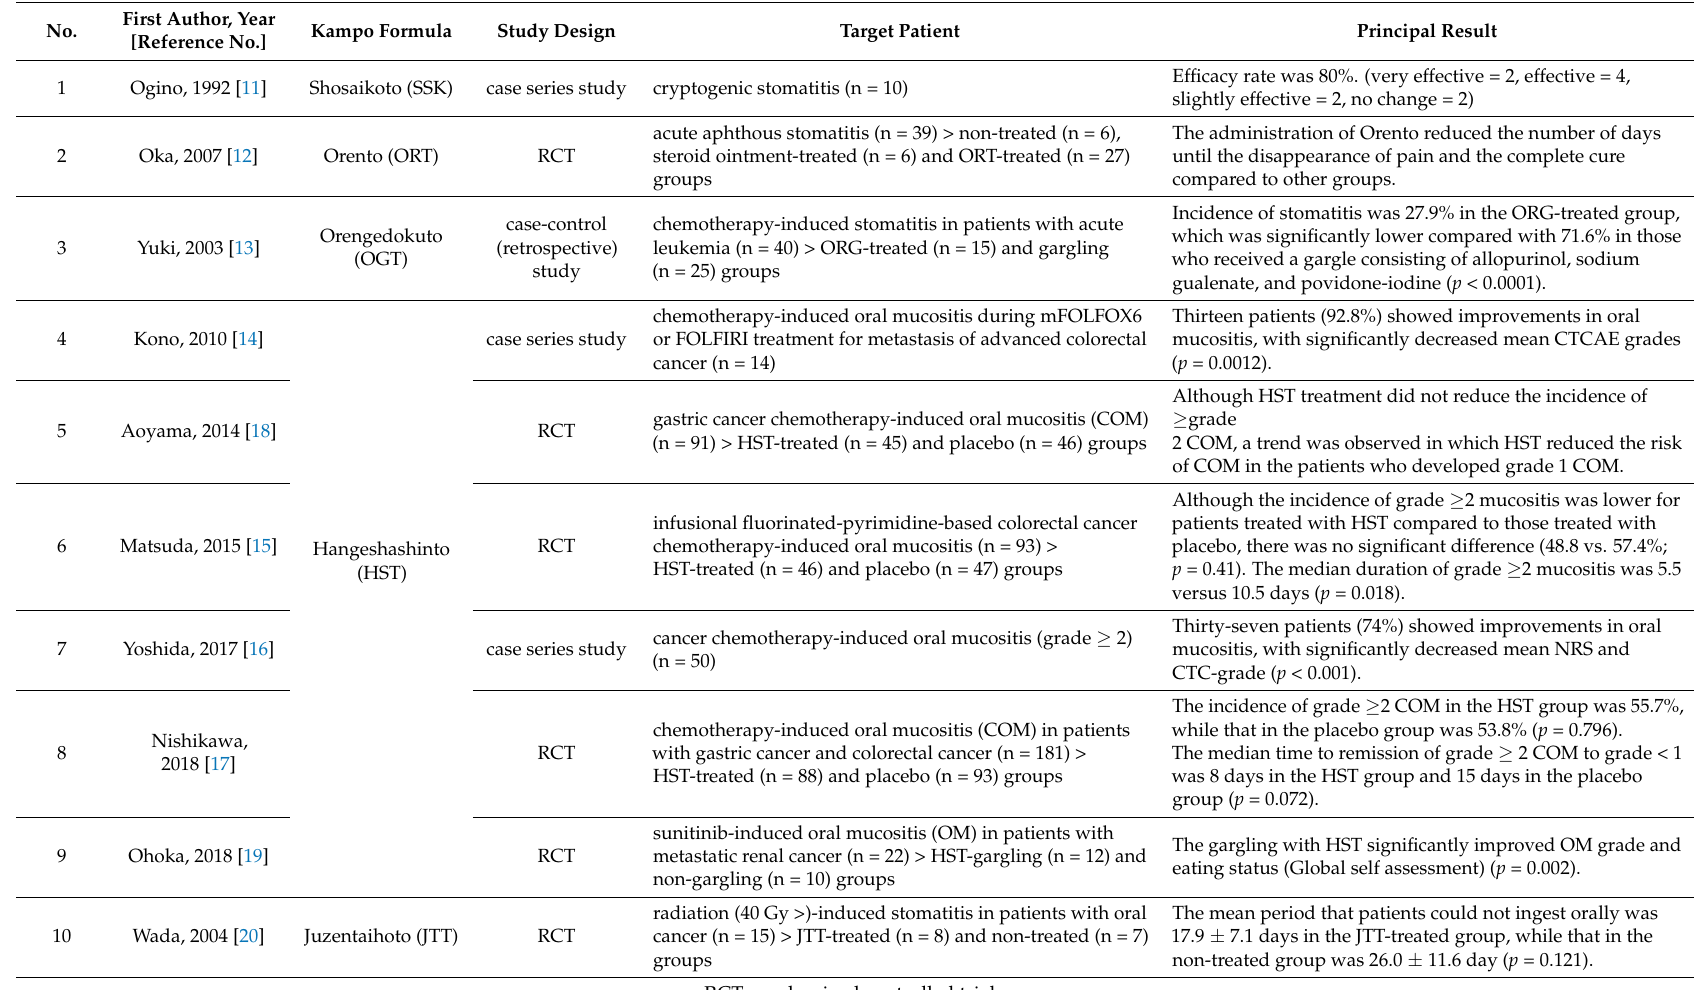
Table 3. Clinical studies reporting the use of the Kampo formulae for the treatment of